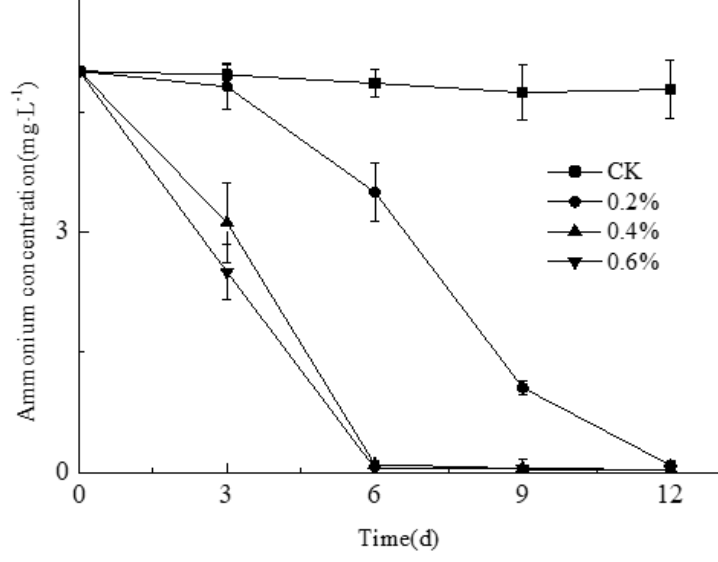
Figure 5. Variation of NH 4+ with time in synthetic ammonium wastewater treated by Smobiisys501.